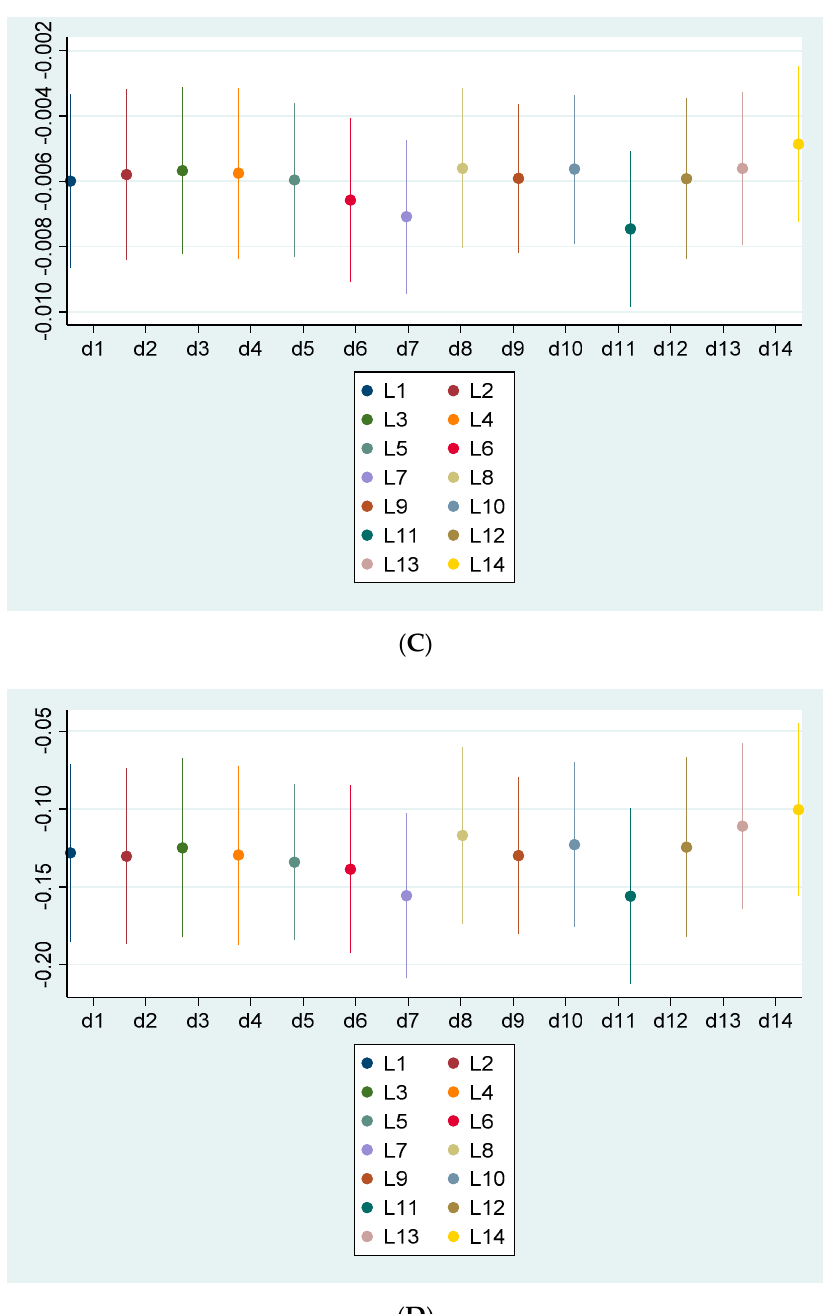
Figure 2. Lagged effect of government responses on the COVID-19 spread. Panel ( A ). Plot of coefficients of the original government stringency index ( STRINGENCY_INDEX ); Panel ( B ). Plot of coefficients of the government stringency index classified into the bottom, medium, and top terciles ( STRINGENCY_TERCILE ); Panel ( C ). Plot of coefficients of the government stringency index adjusted by the median level ( STRINGENCY_MEDIAN_ADJUSTED ); Panel ( D ). Plot of coefficients of normalized government stringency index ( STRINGENCY_STANDARDIZED ).